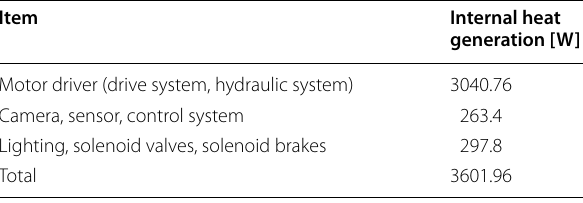
Table 7 Internal heat generation of installed equipment